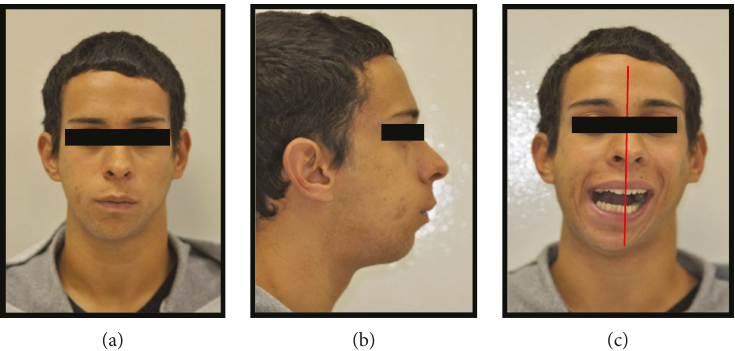
Figure 1: (a), (b), and (c) Preoperative pictures with front and lateral views emphasizing anteroposterior de fi ciency of the jaw and chin, mouth opening limitation, and chin deviation to the right.